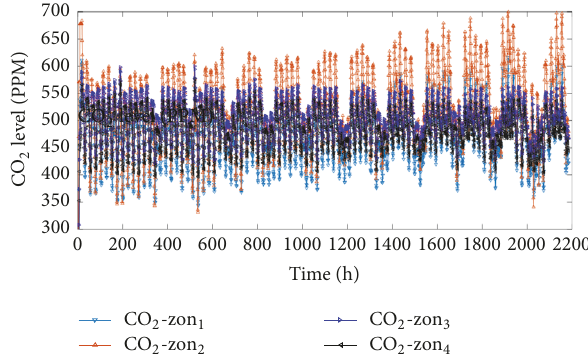
Figure 13: The system outputs response zonal CO 2 level using lsim (sys, u, t, xo) function